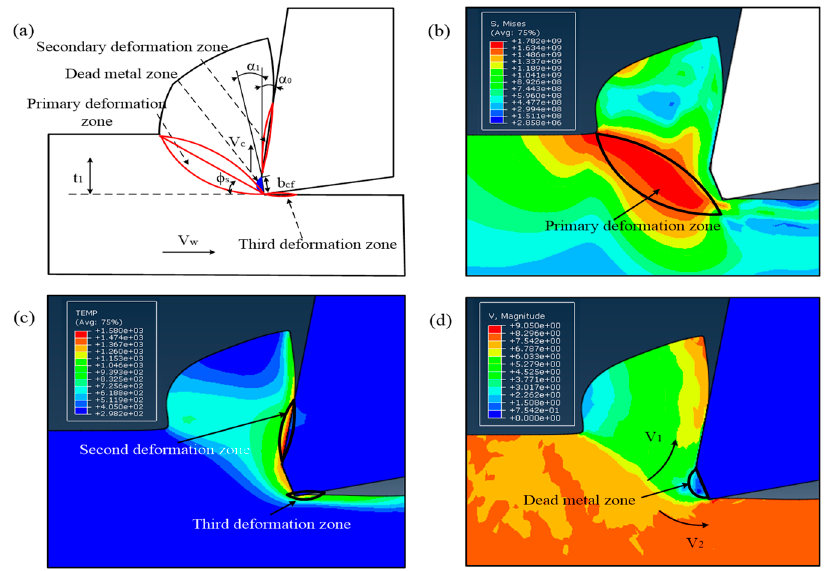
Figure 1. Schematic view of metal cutting process with a chamfered tool. ( a ) Dead metal zone (DMZ); ( b ) Stress contours; ( c ) Temperature; ( d ) Velocity.